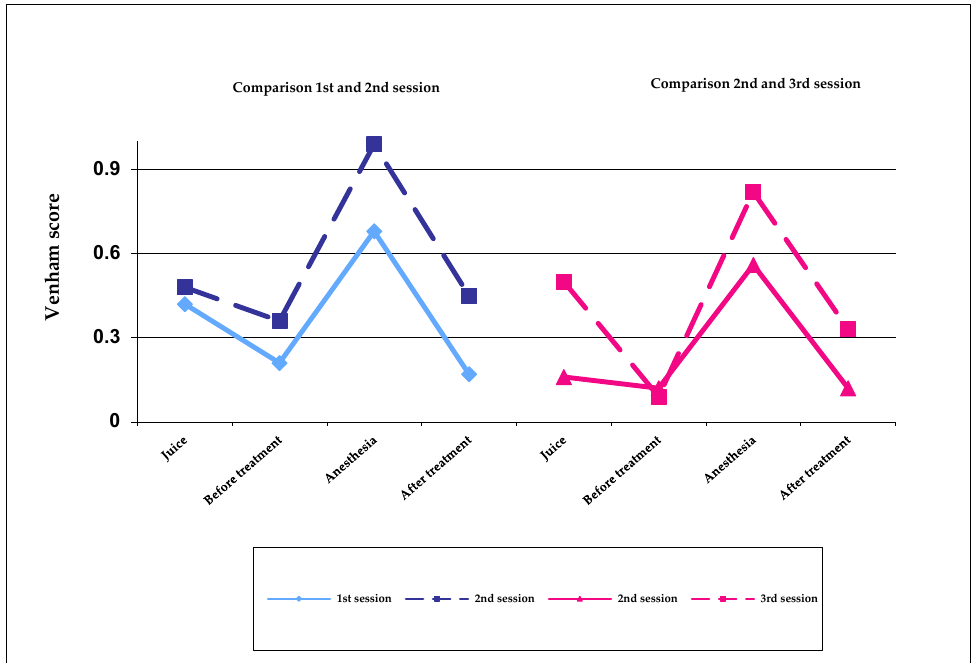
Figure 1. Wilcoxon test to compare treatment sessions.